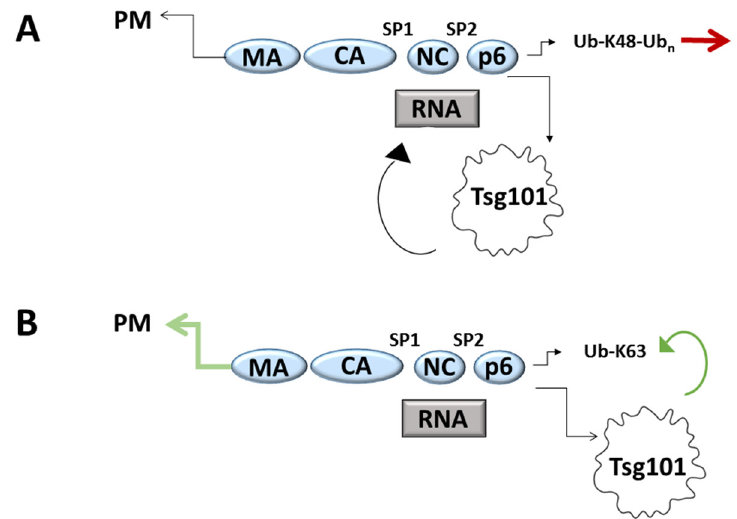
Figure 9. Model: tRNA binding controls Tsg101 recruitment and recruitment of Ub-modified Gag. Panel A , Tsg101 recruitment to the plasma membrane is suggested to be facilitated and stabilized by its ability to interact with the RNA bound to the NC domain in Gag. Under this condition, Lys residues in the C-terminal p6 region are not protected from possible non-productive Ub modification. Panel B , at the viral assembly site, Tsg101 with an available K63-di-Ub region may “cap” a Ub-modified Lys residue on p6 or another partner, sequestering it from further elongation or limiting its extension.